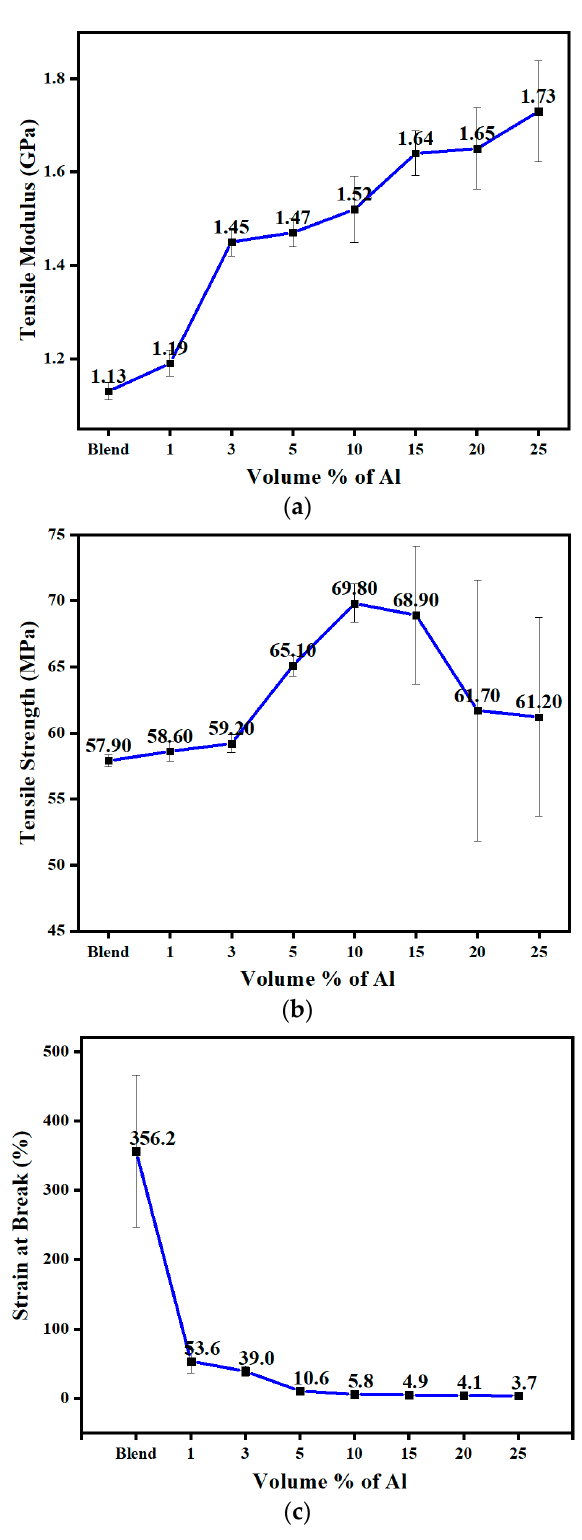
Figure 10. ( a ) The tensile modulus of 60/40 PBT/PET filled with aluminium nano platelets. ( b ) The tensile strength of 60/40 PBT/PET filled with aluminium nano platelets. ( c ) The strain at break of 60/40 PBT/PET filled with aluminium nano platelets.